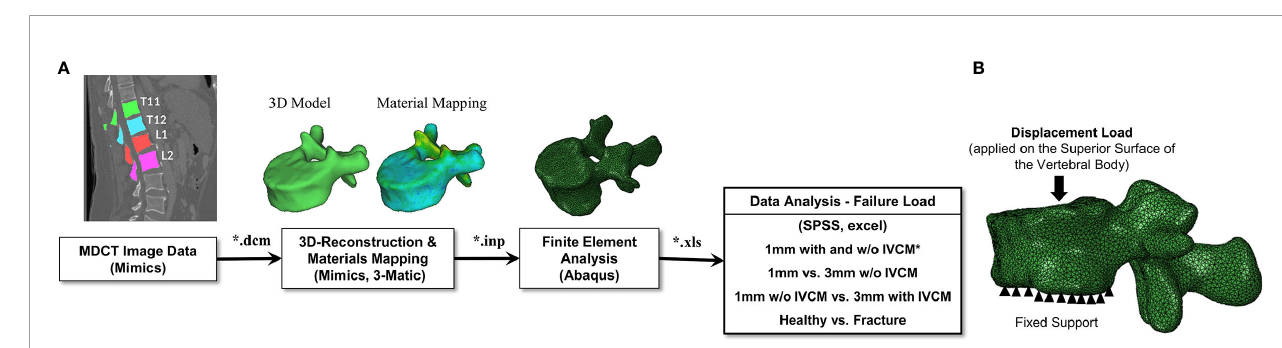
FIGURE 1 | (A) Schematic representation of the data generation and analysis methodology followed in the study. The vertebrae were delineated on the images acquired to generate a 3D model of the geometry to be used in the downstream fi nite element analysis protocol to predict the bone strength. *IVCM means intravenous contrast medium used to acquire contrast enhanced MDCT images. (B) Loading and boundary conditions applied in performing the fi nite element analysis of the full vertebra (with posterior elements). Fixed support represents the zero displacement in all directions at the inferior surface of the vertebral body. Displacement load was applied on the superior surface of the vertebral body to predict the failure